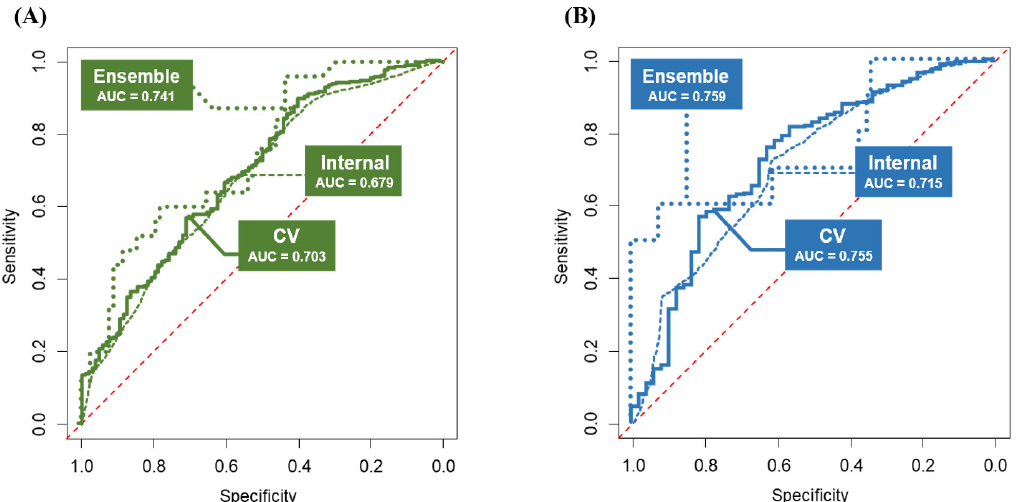
Figure 4. Predictive performance of the developed models. The logistic regression models underwent tenfold cross validation (presented as line) and internal validation with 20% of predivided test set (presented as dash). The ensemble models also underwent internal validation with 20% of predivided test set (presented as dots): ( A ) ROC curves with the AUC values for 5-year PFS; ( B ) ROC curves with the AUC values for 5-year OS.